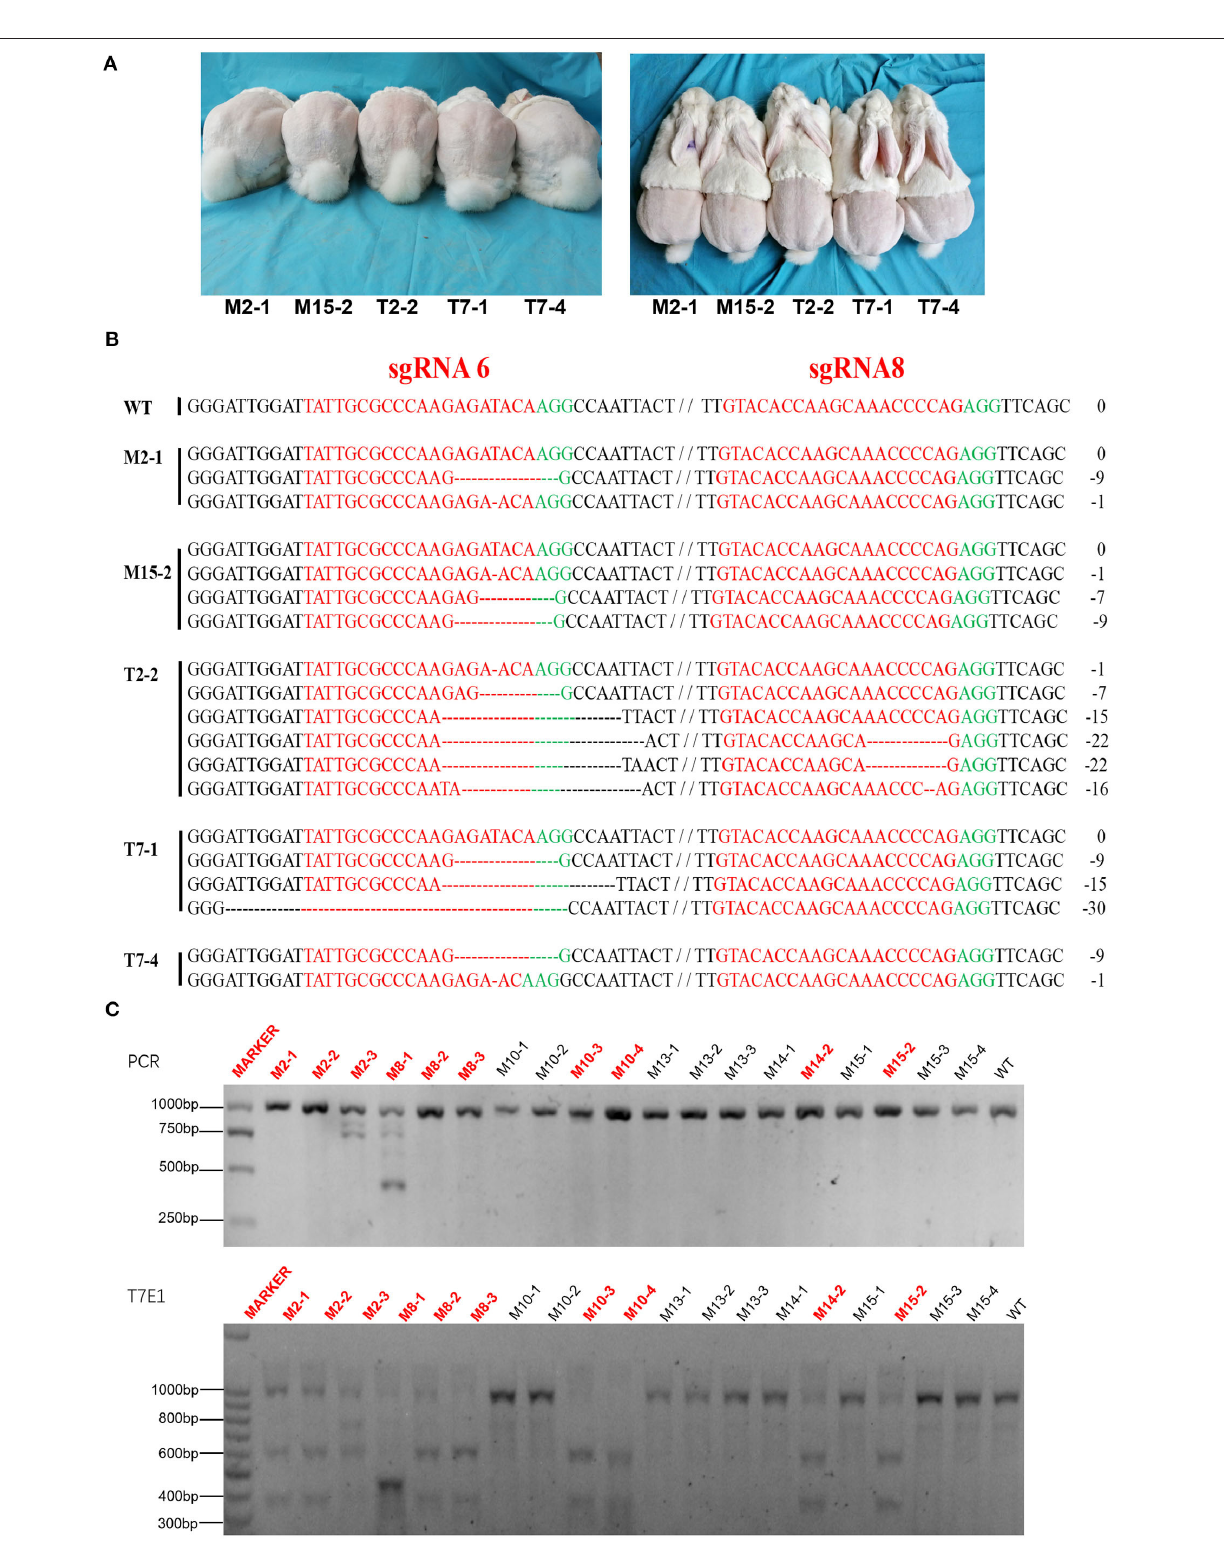
Frontiers in Veterinary Science |